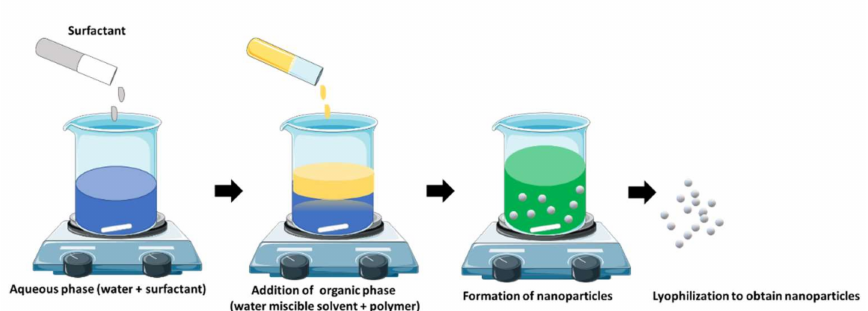
Figure 7. Nanoprecipitation method.